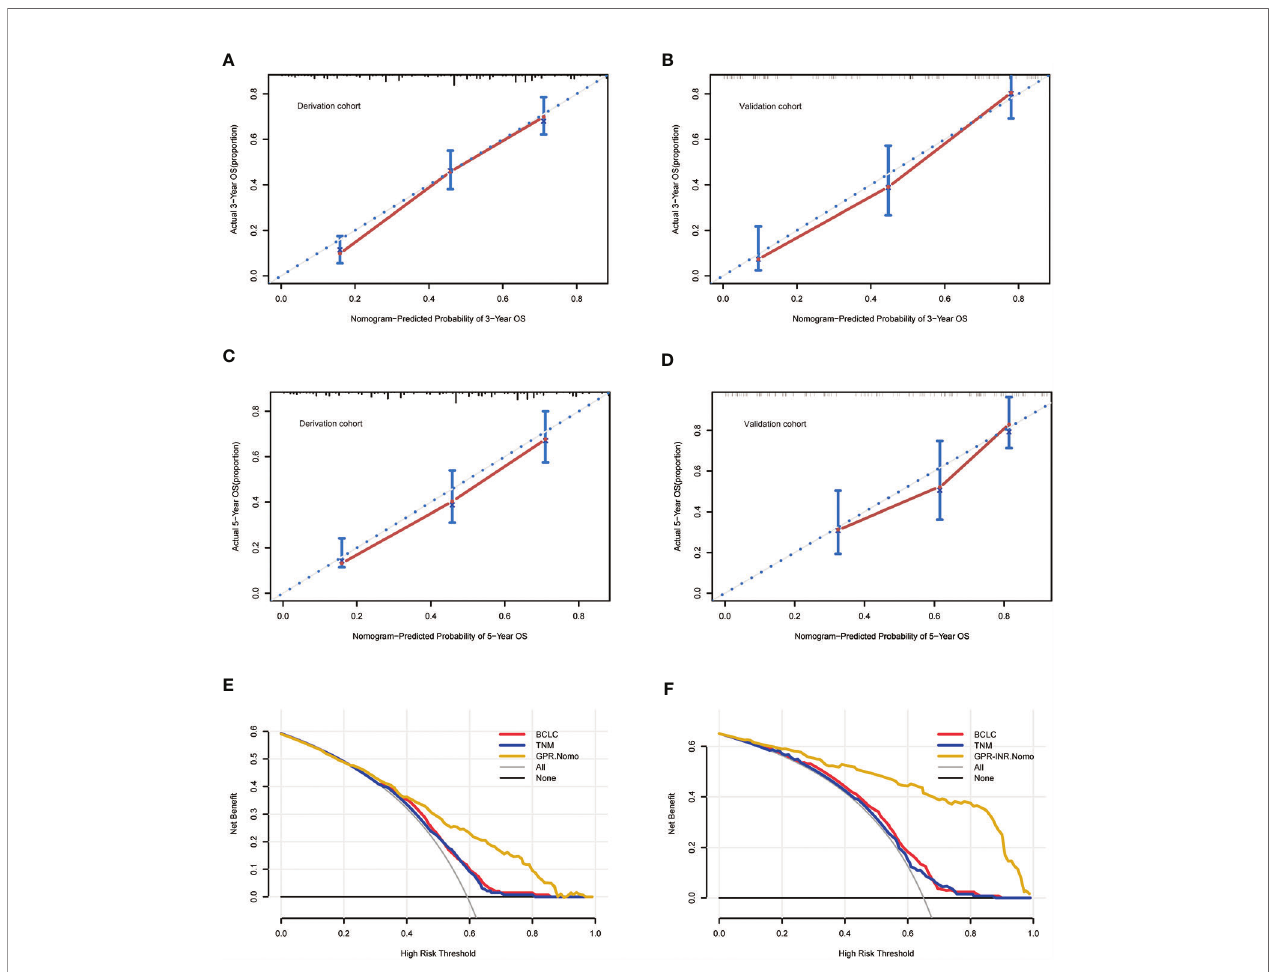
FIGURE 4 | The calibration curves for predicting the OS of the patients at 3 years in the derivation set (A) and validation set (B) and at 5 years in the derivation set (C) and validation set (D) . The decision curve analysis for the BCLC staging system, the AJCC 8 th TNM system and the GPR-INR nomogram in the derivation set (E) and the validation set (F)